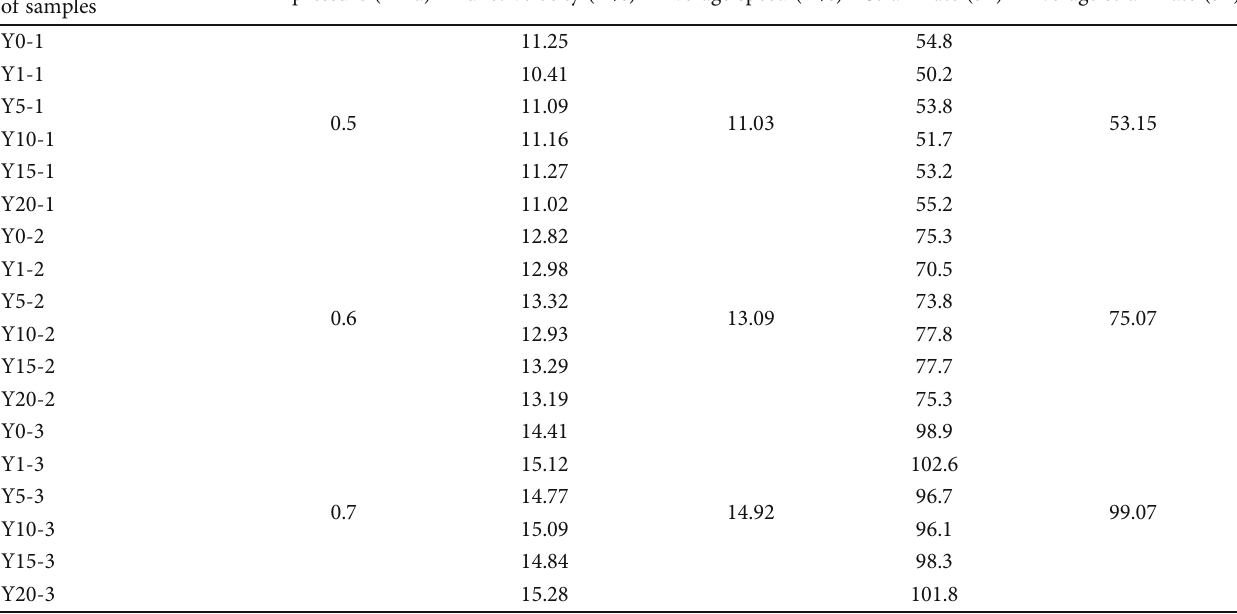
Table 2: Bullet velocity and strain rate under di ff erent pressure.